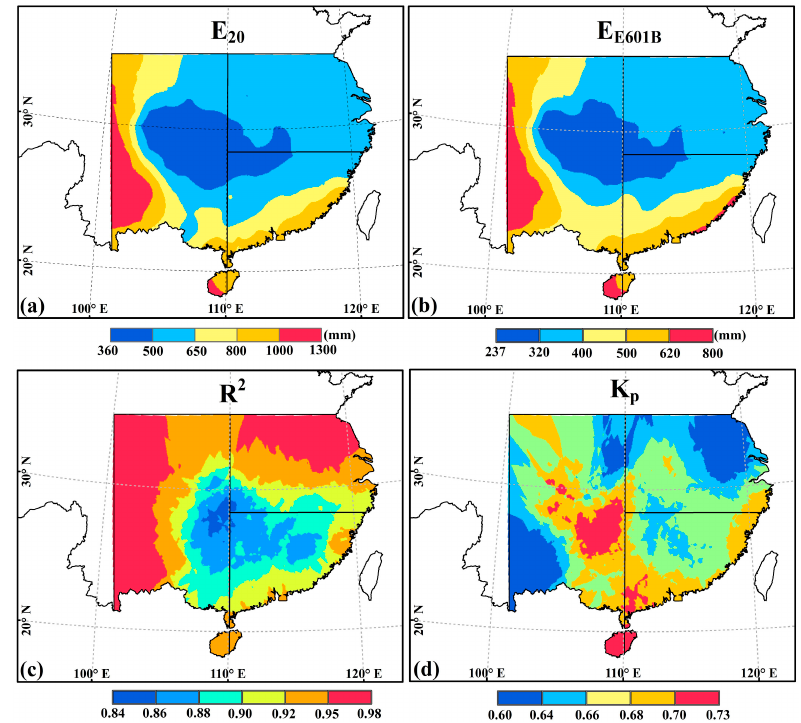
Figure 6. Spatial distributions of φ 20 ( a ) and E601B ( b ) evaporation; the correlation coefficient R 2 ( c ); and the conversion coefficient K p ( d ) between E601B and φ 20 evaporation in the cold season (October–April).